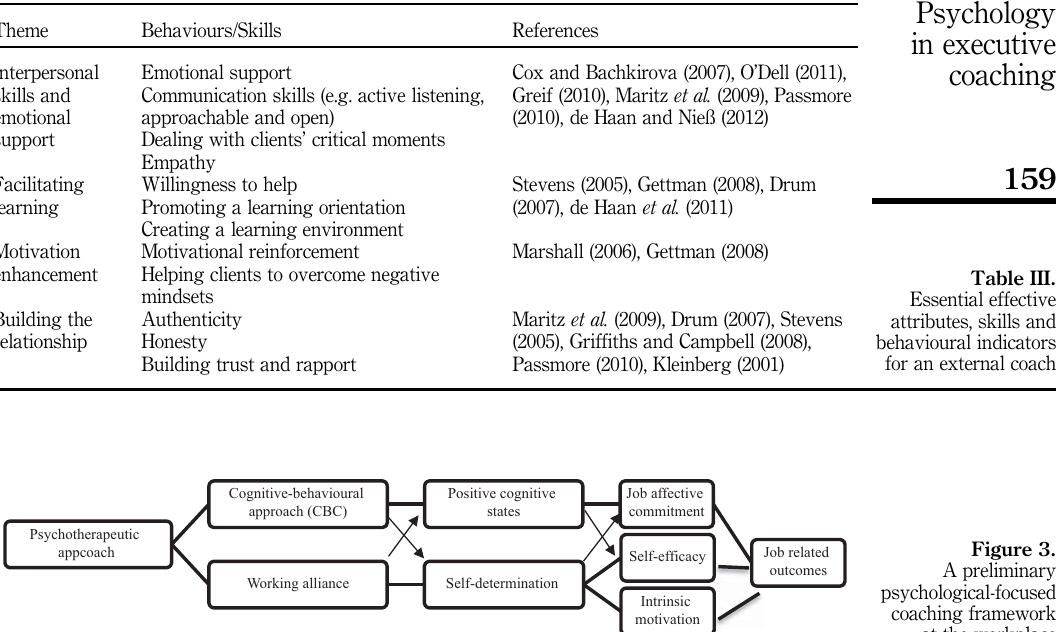
Figure 3. A preliminary psychological-focused coaching